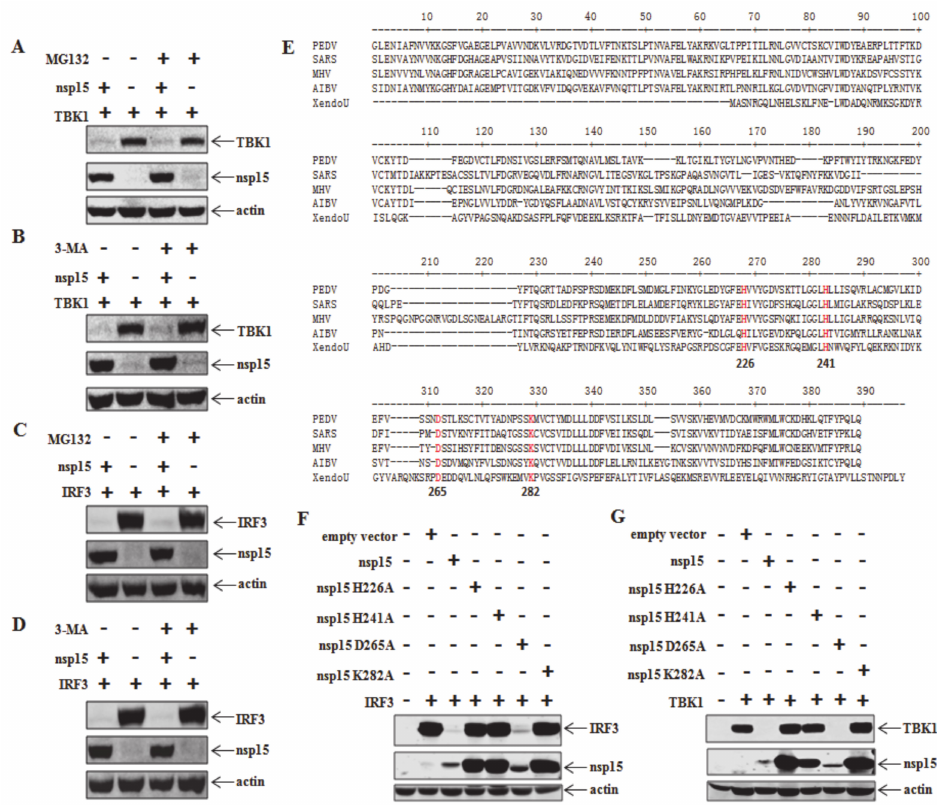
Figure 3. PEDV-induced reduction in TBK1 and IRF3 expression is due to PEDV nsp15 endoribonuclease activity, but not proteasome or autophagy-mediated mechanisms. ( A , C ) HEK293T cells were co-transfected with nsp15 (Flag tagged) and TBK1 or IRF3 (HA tagged) and were treated with the proteasome inhibitor MG132 (2 µ M) or carrier control DMSO. Detergent lysates were collected and subjectedtoreducingSDS-PAGEandimmunoblottingwithanti-flagandHAantibodies. ( B , D )HEK293T cells were co-transfected with nsp15 (Flag tagged) and TBK1 or IRF3 (HA tagged) and were treated with 3-MA (5 mM) for further culture. At 36 h post transfection, cell lysates were subjected to blotting with corresponding antibody. ( E ) Alignments of the nsp15 orthologs from several coronaviruses and X. laevis EndoU. The amino acid sequence of the PEDV nsp15 (PEDV, KT323979) was aligned with orthologs of severe acute respiratory syndrome coronavirus (SARS, KF514422), murine hepatitis virus (MHV, KF268339), avian infectious bronchitis virus (AIBV, NC_001451) and Xenopus laevis (XendoU,